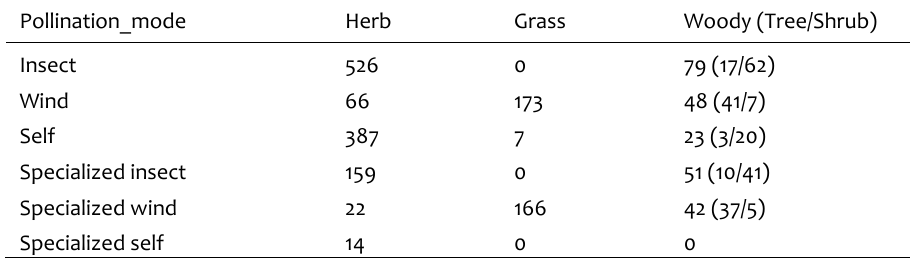
The number of species with different pollination modes and growth forms.